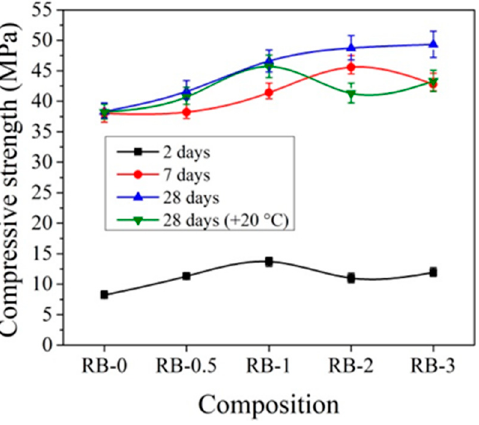
Figure 11. Compressive strength of concrete with CEM IIR samples at +5 °C initial curing (28 days (+20 °C)—reference samples prepared and cured at +20 °C).